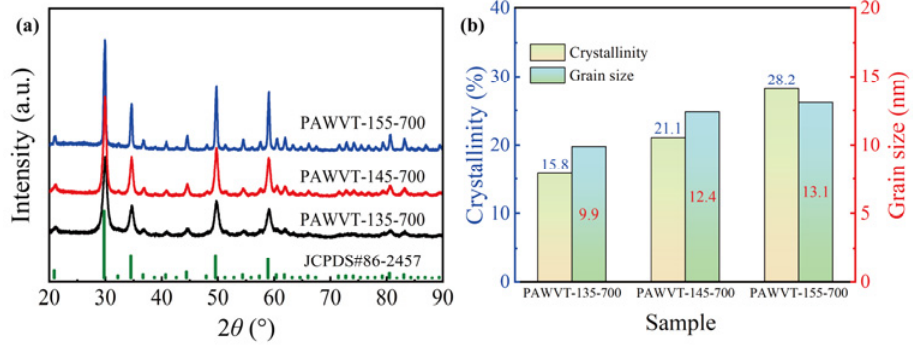
Fig. 5 (a) XRD patterns and (b) grain sizes and crystallinities of the pretreated samples after heat treatment at 700 ℃ for 2